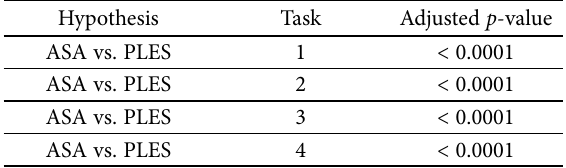
Table 13. Multiple comparisons with the Bergmann–Hommel procedure for group